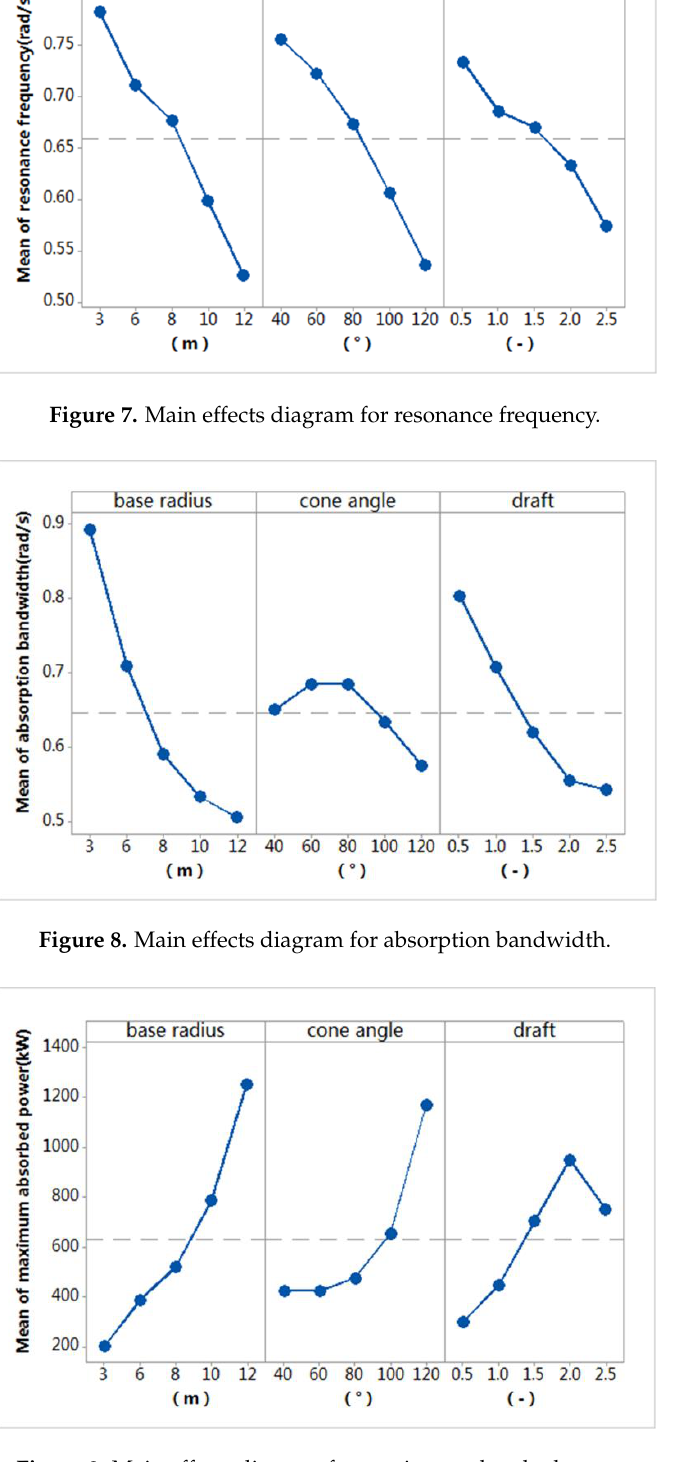
Figure 9. Main effects diagram for maximum absorbed power. Based on the above results, the response surface optimization design is performed. The response surface type adopted is the central composite design (CCD). Since the energy absorption efficiency and the draft are always negatively correlated, the draft is fixed at 0.5 and the performance of the buoy with a radius in the range [6, 8] and angle in the range [60, 80] is optimized. The response surface of the buoy’s objective function with respect to radius and angle is shown in Figure 10 and the response surface optimizer is used to predict the optimal result, as shown in Figure 11. The optimal geometric configuration with a radius of 6.7 m, an angle of 80° and a draft ratio of 0.5 (the draft depth of 3.35 m) is finally obtained.